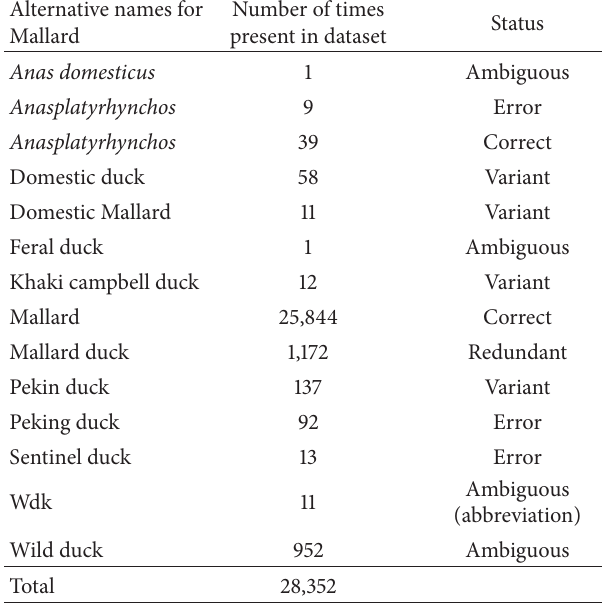
Table 1: All the alternative instances of the host Mallard in all of the entries in the knowledge base of FluKB. The standardized name for the search key is Mallard ; Anas platyrhynchos ;